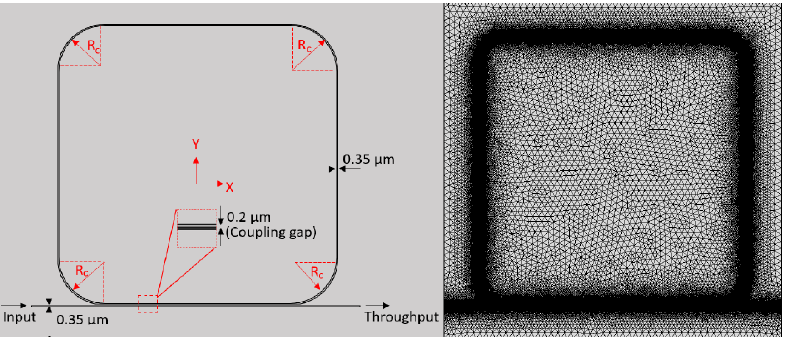
Figure 7. RCSS R c = 15 µ m; ( left ) Schematic with dimensions; ( right ) Hybrid meshing for FEA